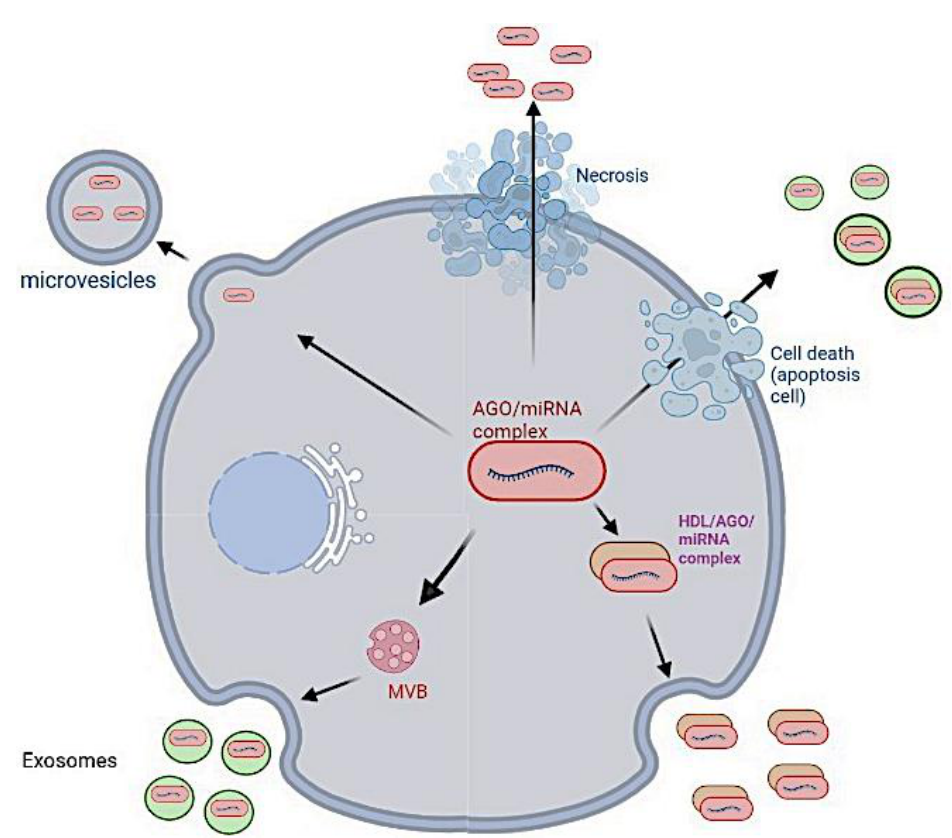
Figure 12. Excretion of the microRNas out of the cell [154].